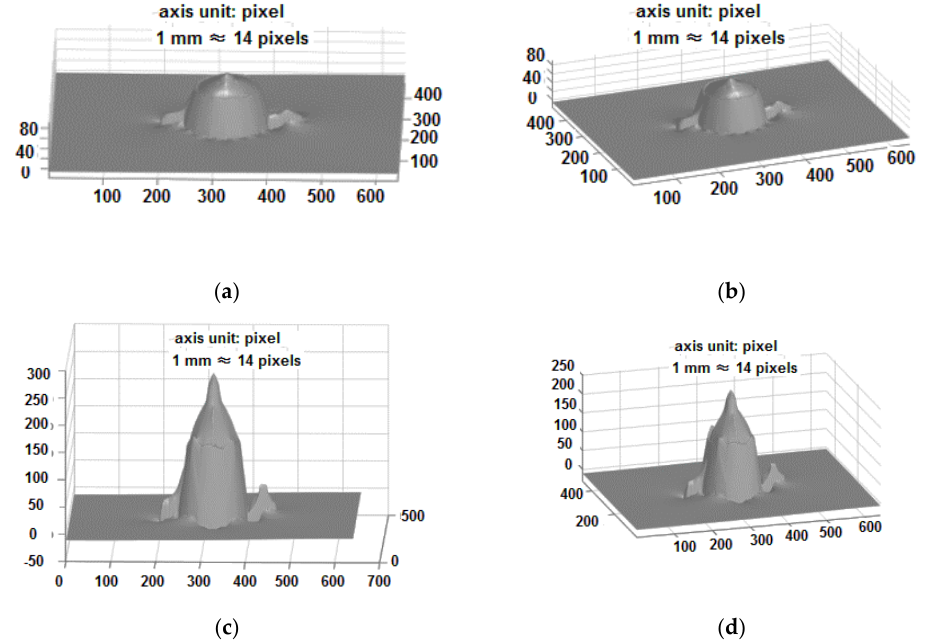
Figure 7. The 3-D reconstruction of a simulated teapot: ( a , b ) with the proposed shadow detection, ( c , d ) without shadow detection.